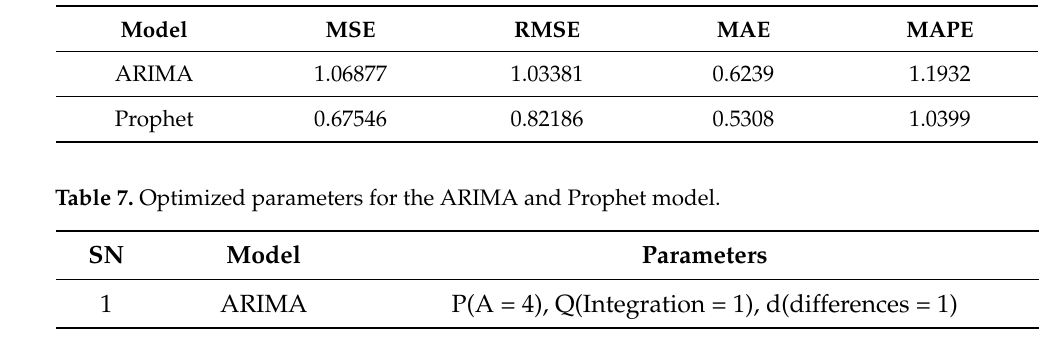
Table 6. Performance comparison of the ARIMA and Prophet model for different evaluation parameters.